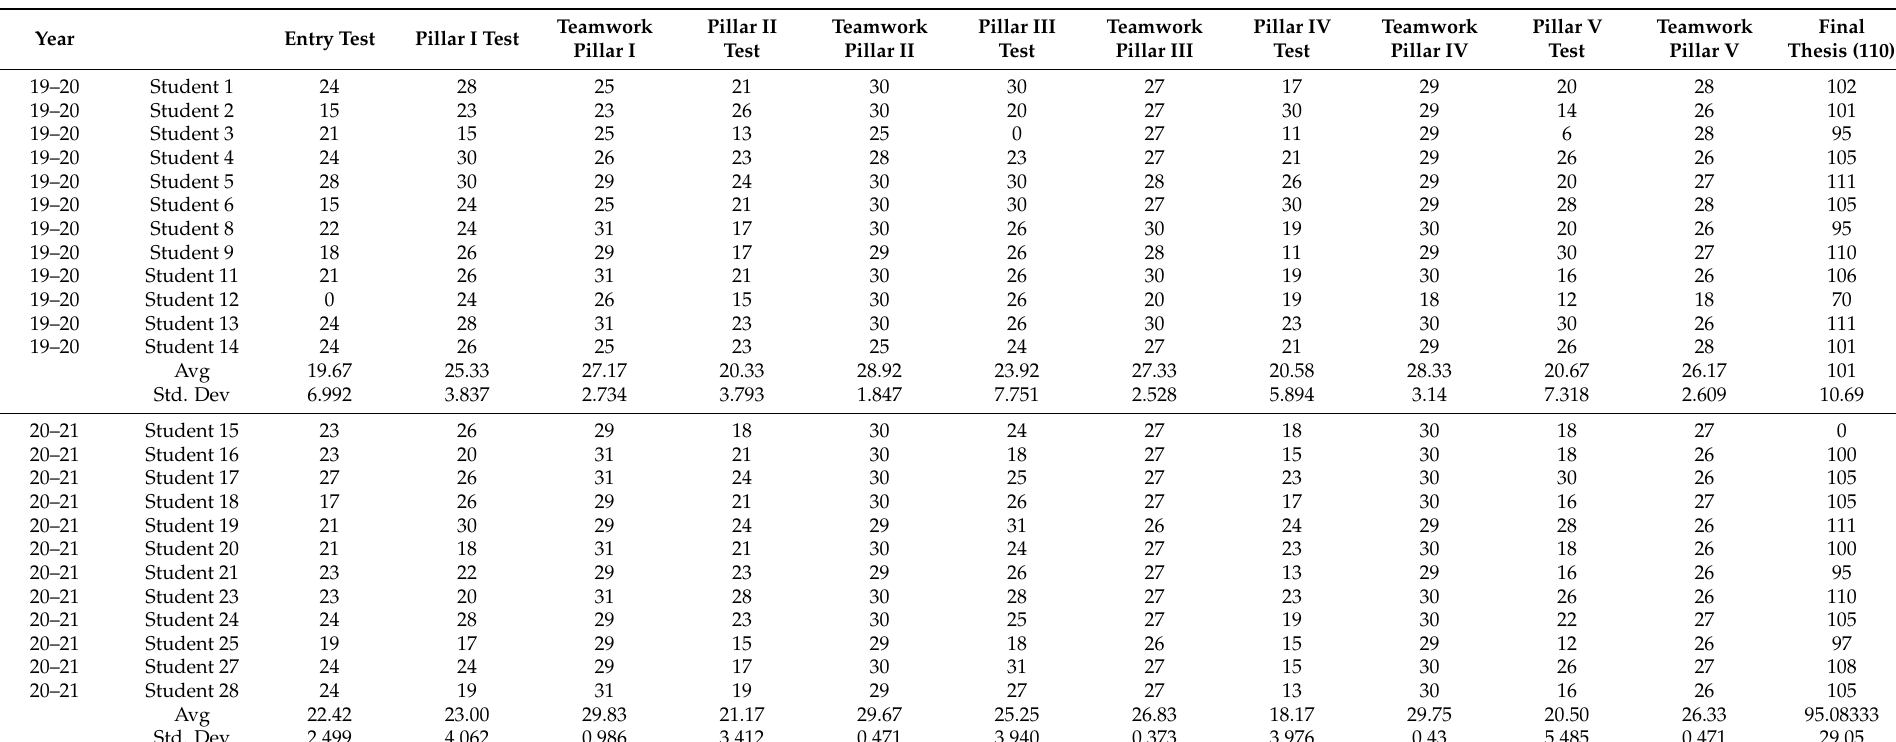
Table 2. The table contains the cleaned data from the students. Each column represents the mark obtained by the student in the given course. The last two lines at the bottom of each table represent the average and standard deviation for each